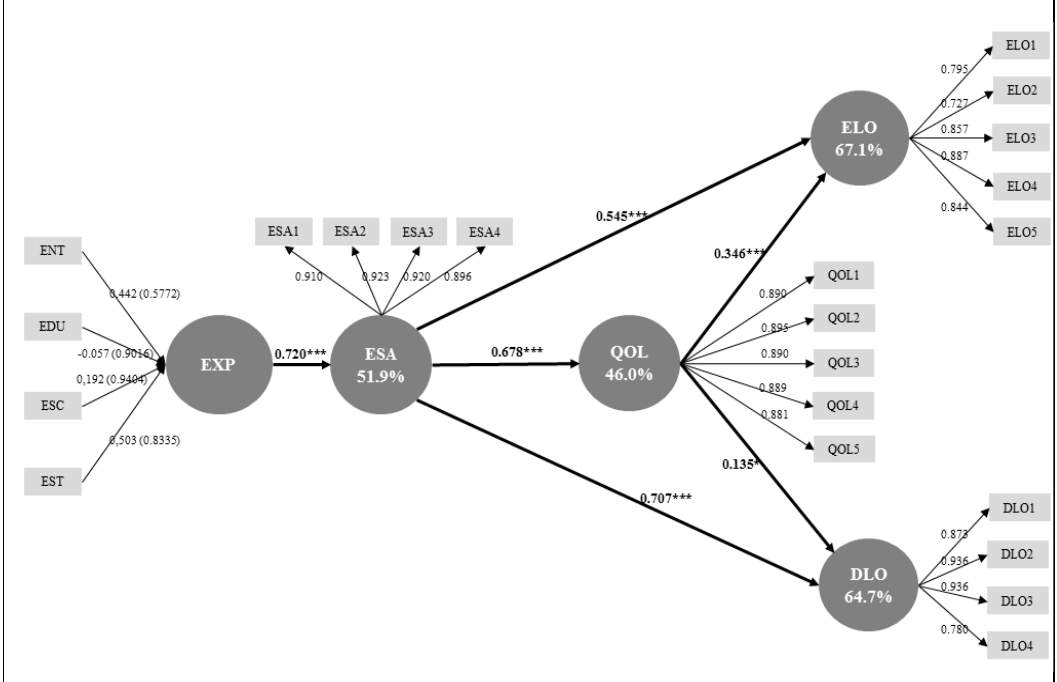
Figure 2. Graphical summary of the model assessment. * ENT: Entertainment. EDU: Educational.